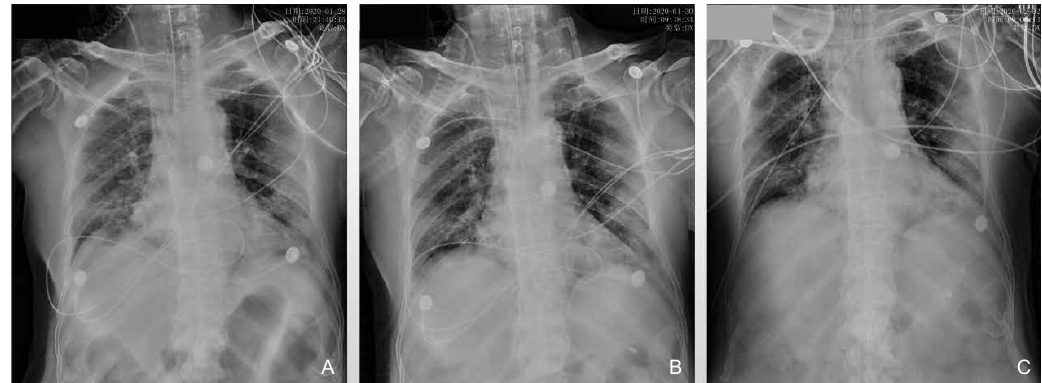
Figure 1 Early stage case plain film of an 81-year-old hospitalized male, 2 days after disease onset. (A) The first image showed hyperdense shadows distributed mainly in the external fields of the bilateral lungs. The right lung showed frosted hyaline changes. On the second (Fig. 1B) and fourth day (Fig. 1C), the lesions in the right lung were reduced in size with decreased density, while the lesions in left lung field had no obvious changes.